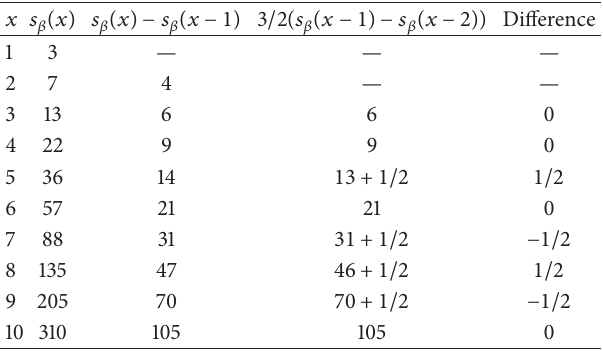
Table 2: The structure of the space sequence of machine 666 364 in (3,2) space.